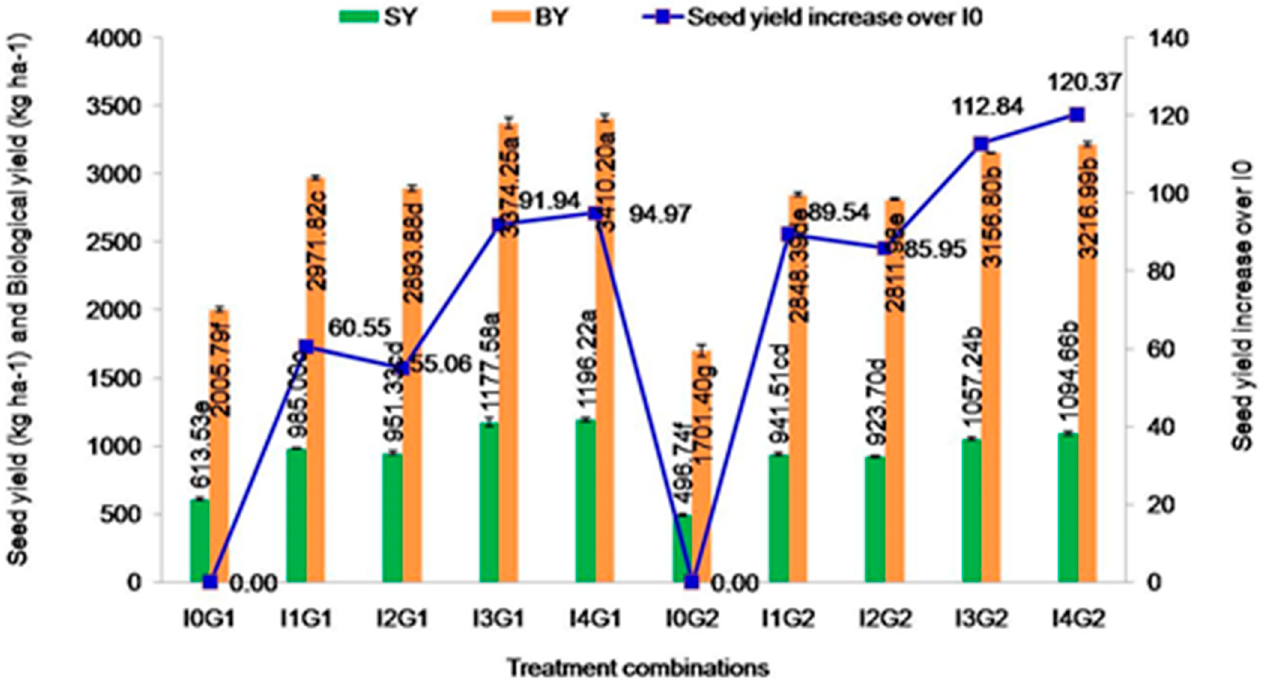
Figure 7. Seed yield (kg ha − 1 ) and biological yield (kg ha − 1 ) of selected mung bean genotypes at harvest under variable irrigation (Data followed by the same letter are not differed significantly by LSD test at p < 0.05).